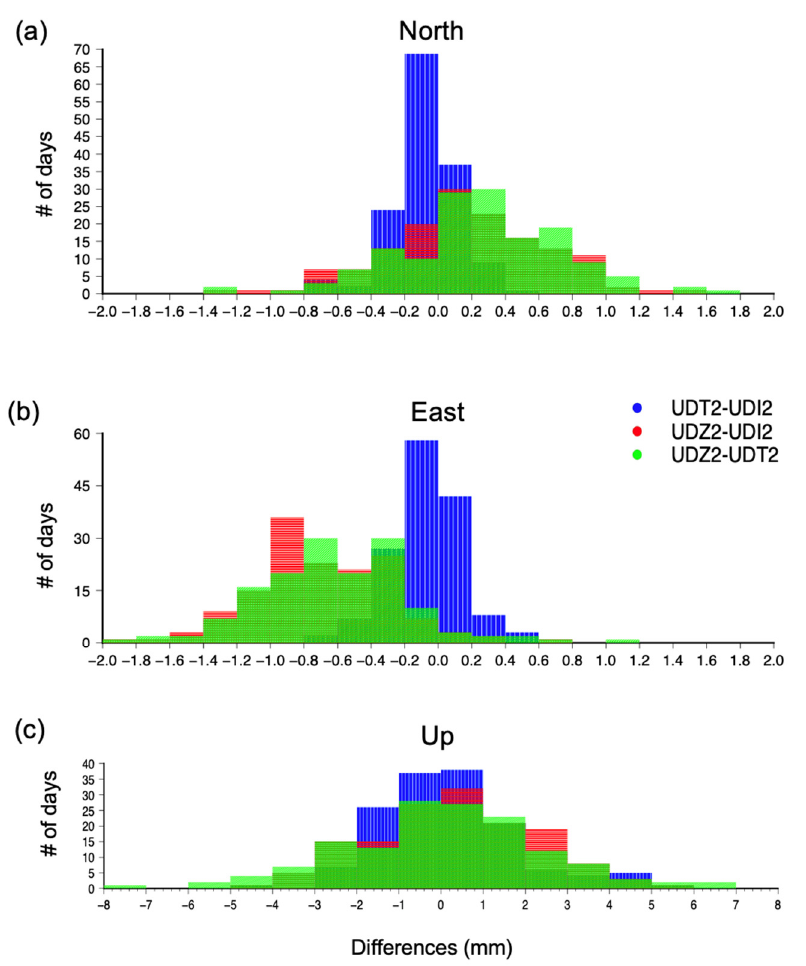
Figure 4. Histograms of the differences between UDT2 and UDI2, UDZ2 and UDI2, UDZ2 and UDT2, for the ( a ) North, ( b ) East, and ( c ) Up displacement components. Table 2. Differences in the daily displacements estimates between the station in the first column (site 1) and the station in the second column (Site 2). Last two columns indicate the mean and standard deviation of the